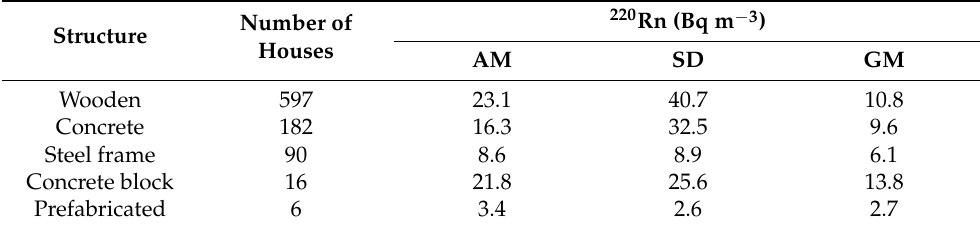
Table 2. The mean annual 220 Rn concentration for each type of house.